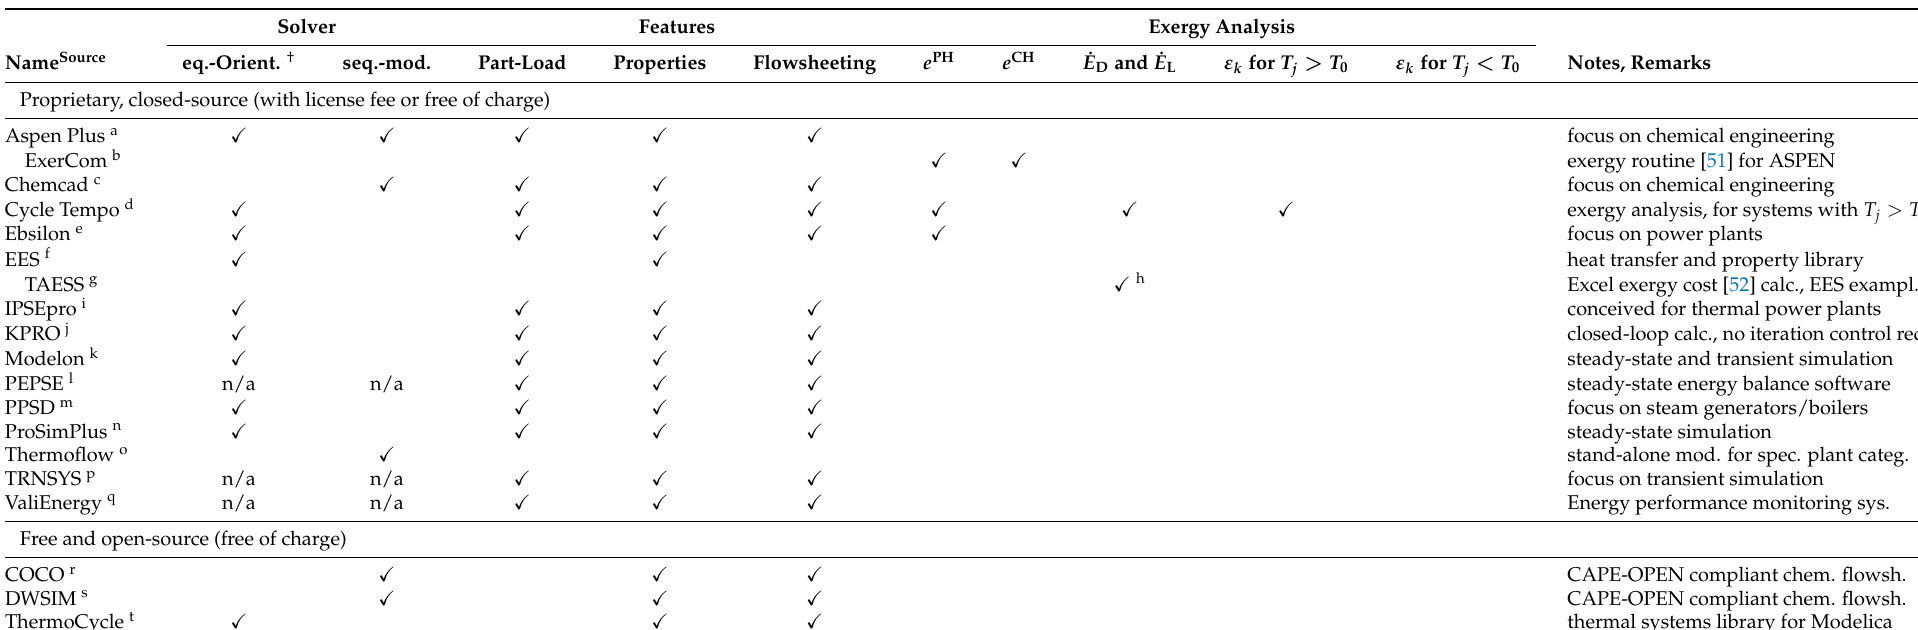
Table 1. Frameworks for the simulation of steady-state processes in thermal conversion systems.